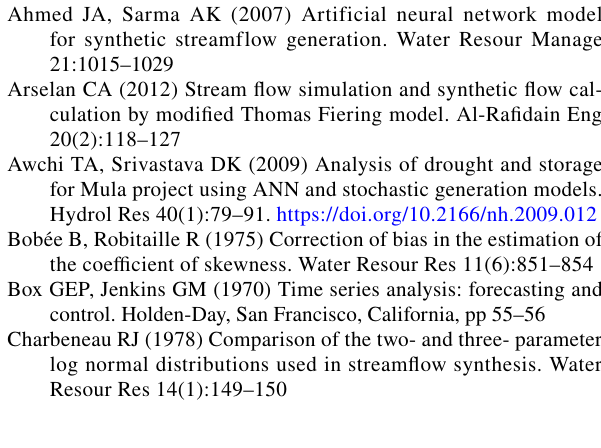
Fig. 19 Historical and generated monthly cross-correlations of flows in Konar and Barakar (multi-site model)